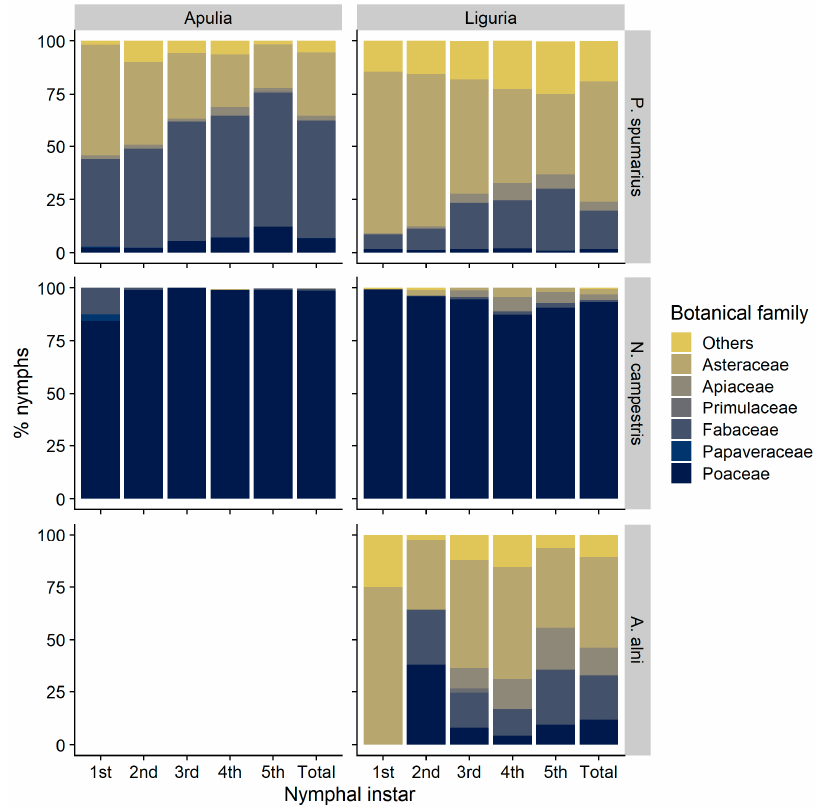
Figure 1. Relative percentage of nymphs of spittlebug species ( Philaenus spumarius , Neophilaenus campestris , Aphrophora alni ) on the most selected plant families in Apulia and Liguria olive groves.